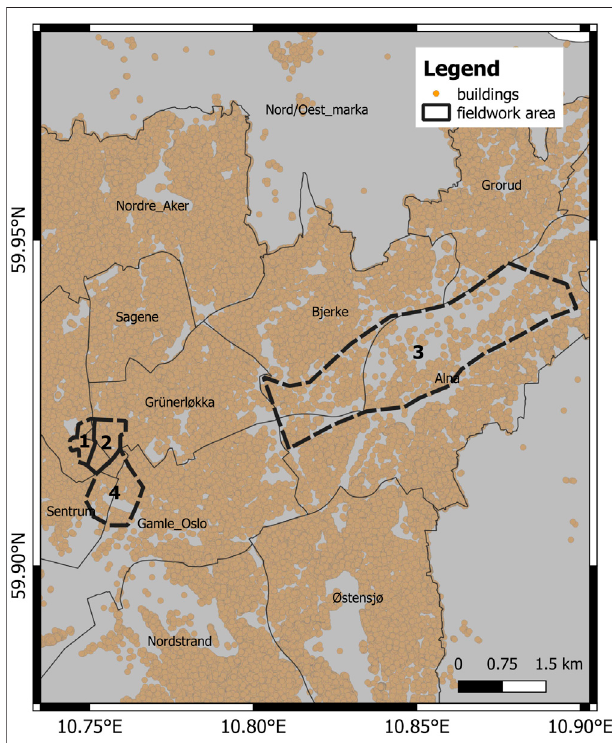
FIGURE 3 | In the fi gure, the fi eldwork area is represented with dashed